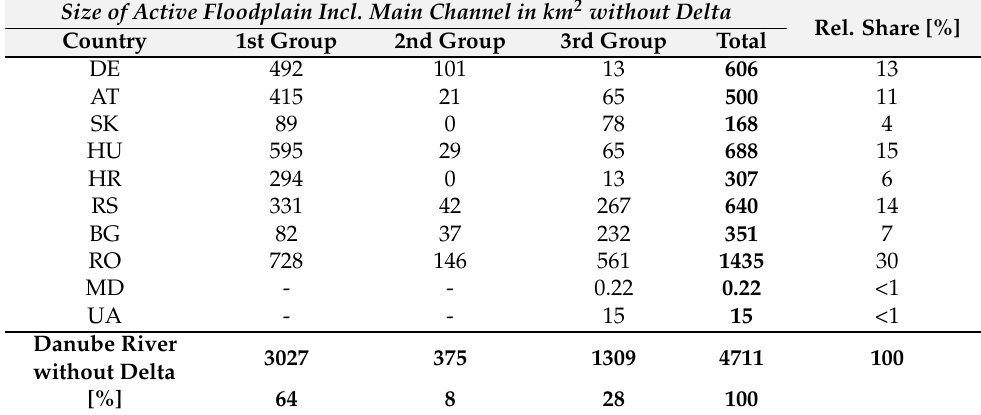
Table 3. Comparison of the active floodplains of the Danube River (without the Delta) in the riparian states. In the 1st group, all active floodplains fulfill the two delineation criteria (ratio factor, minimum size); 2nd group, the minimum size is not fulfilled; 3rd group, neither the ratio factor nor the minimum size is fulfilled. Country codes: DE = Germany, AT = Austria, SK = Slovakia, HU = Hungary, HR = Croatia, RS = Serbia, BG = Bulgaria, RO = Romania, MD = Moldova, UA = Ukraine. The relative share in the last column presents the proportion of the total floodplain area in a country in relation to the total floodplain area along the Danube River. Size of Active Floodplain Incl. Main Channel in km 2 without Delta Country 1st Group 2nd